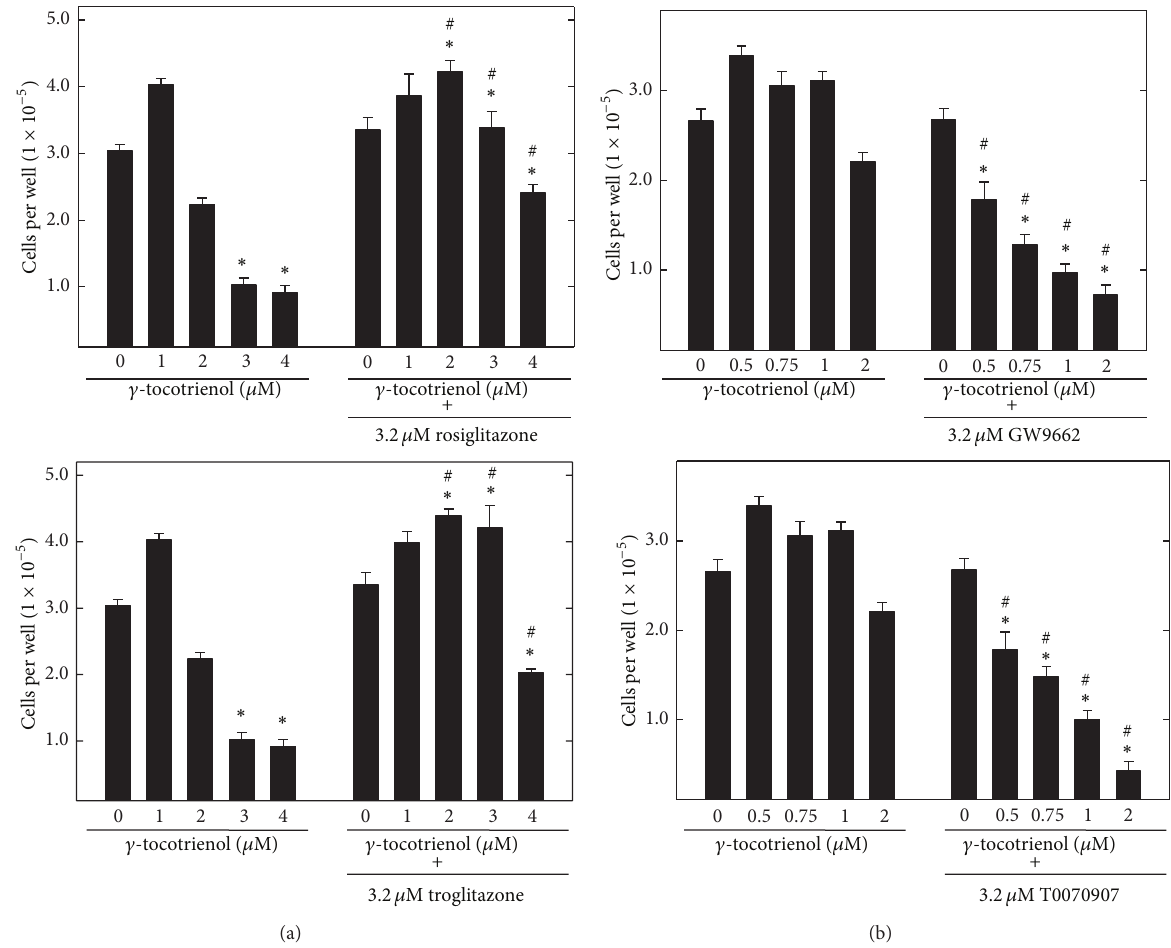
Figure 2: Treatment effects of 𝛾 -tocotrienol, (a) PPAR 𝛾 agonists and (b) PPAR 𝛾 antagonists in combination in +SA cells. +SA cells were plated at a density of 5 × 1 0 4 (6 wells per group) in 24-well plates and exposed to treatment media for a 4-day period. Afterwards, viable cell number was determined using MTT colorimetric assay. Vertical bars indicate the mean cell count ± SEM in each treatment group. ∗ 𝑃 < 0.05 as compared with vehicle-treated controls and # 𝑃 < 0.05 as compared to their corresponding control treated with 𝛾 -tocotrienol